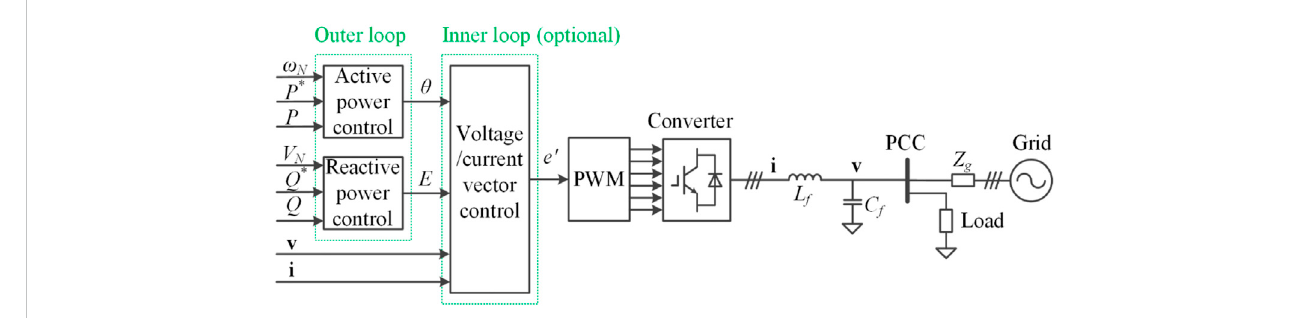
FIGURE 3 Generalized control structure of a GFM converter (Rosso et al., 2021).